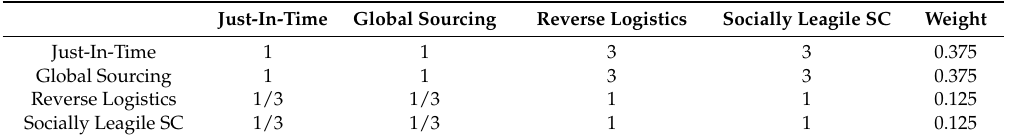
Table A1. Pairwise Comparison of Alternatives w.r.t. sub-criterion Sourcing.